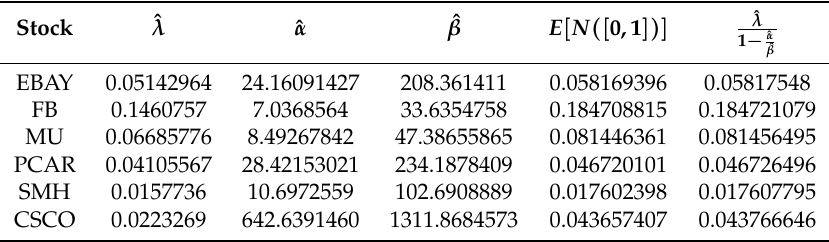
Table 1. Calibration Result of Hawkes